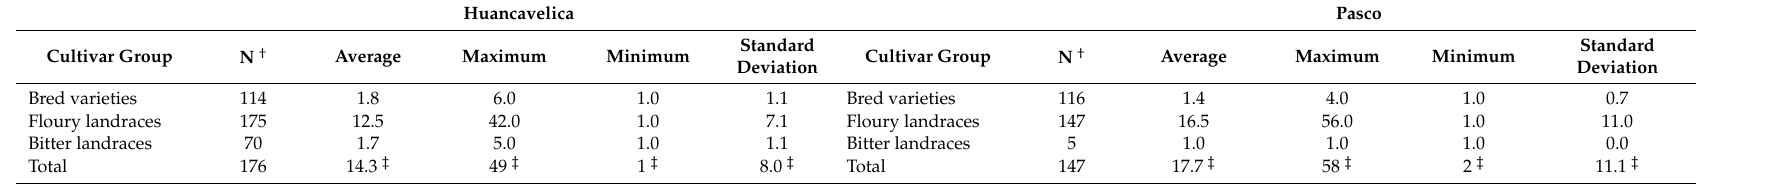
Table 5. Number of distinct cultivars managed per household by cultivar group and landscape.